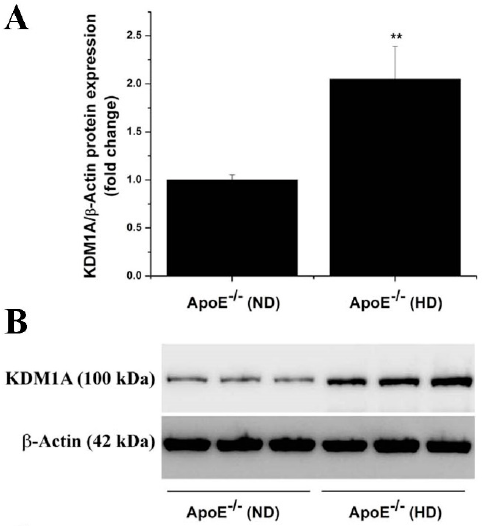
Figure 4. The relative abundance of LSD1 (KDM1A) protein is elevated in atherosclerotic ApoE-/- mice. ( A ) Western blot assay-associated densitometric analysis indicating the augmented level of LSD1 (KDM1A) protein in the atherosclerotic aorta of ApoE-/- mice after 14 weeks on high-fat, cholesterol-rich diet. ( B ) Representative immunoblot showing the elevated level of LSD1 (KDM1A) protein in the aorta of ApoE-/- (HD) as compared with ApoE-/- (ND) mice. n = 3, ** p < 0.01. p -value was taken in relation to ApoE-/- (ND) condition.